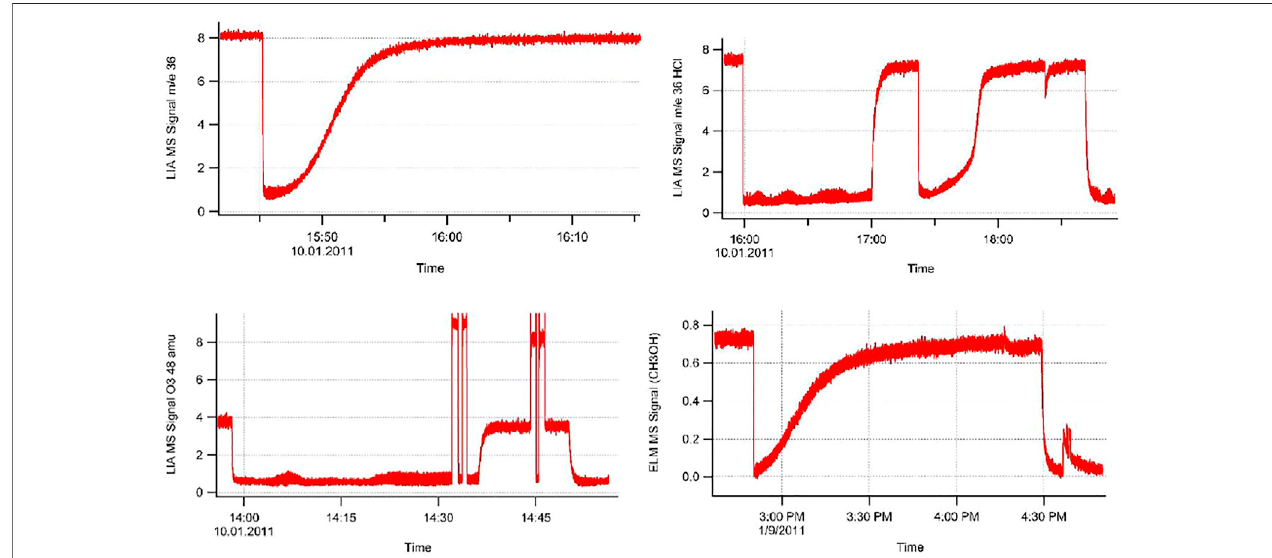
FIGURE 9 | Examples of raw uptake data of Ag Nanoparticles (BET surface area = 5.52 m 2 /g) and CH 3 OH on TiO 2 Hombikat (undoped): opening and closing the SC isself-explanatory. Upperleft : Probe for OH-groups onAg 0 using HCl at m/e = 36 amu on avirgin sample, 1 mm Ø ori fi ce,SC at 16:09 h; Upperright : HCl probe for OH-groups after oxidation of Ag 0 nanoparticles using O 3 , three uptake episodes are shown, 1 mm Ø ori fi ce. Lower left : oxidation of Ag NP ’ s by O 3 on long time scale: 10 ML ’ s at F i = 7.35 × 10 15 molecule s − 1 in 4 mm Ø ori fi ce KFR. Uptake goes on inde fi nitely. At approximately 14:32 and 14:44 p.m. the LIA signal was changed temporarily to m/e = 32 amu in order to observe O 2 level with O 3 on and off, respectively. Lower right : CH 3 OH uptake monitored at m/e = 31 amu on 6.85 mg TiO 2 Hombikat (undoped, s8 in Supplementary Appendix A7 ) in 1 mm Ø ori fi ce KFR. SC closed at 3:58 p.m. At 4:40 p.m. spontaneous desorption is observed upon opening SC. Nota bene: total ELM rather than LIA MS signal (in red) recorded